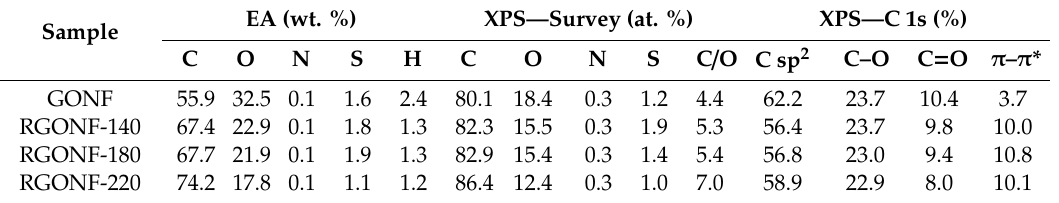
are listed in Table 3. Based on the results of N 2 physisorption, GONF and RGONFs exhibited type